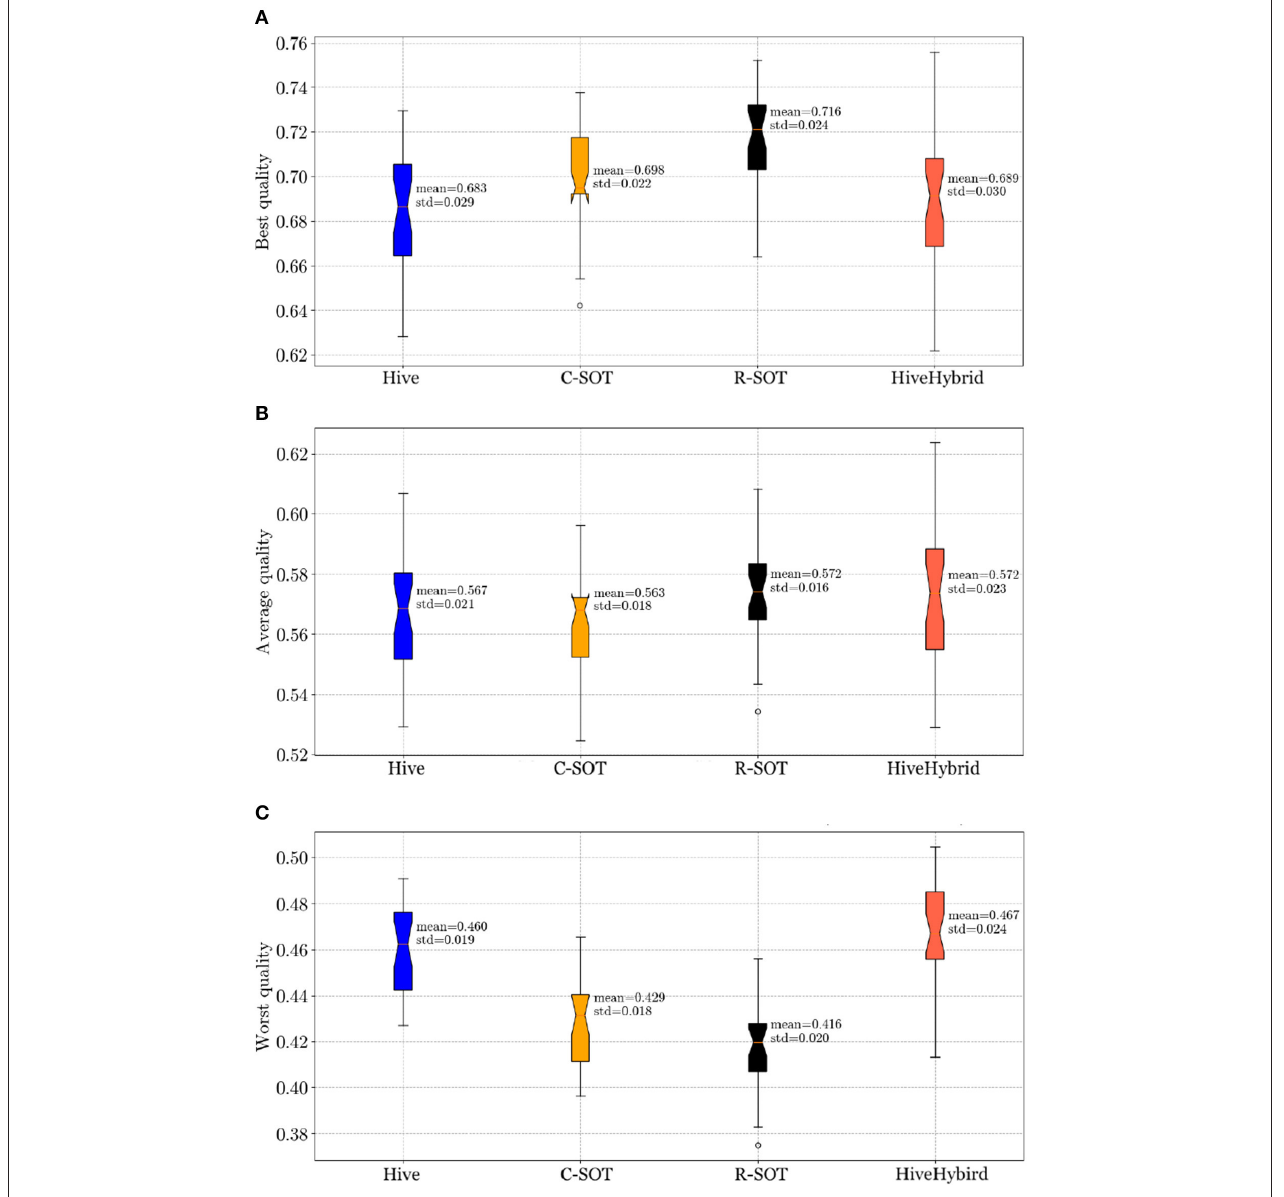
FIGURE 2 | Teamwork quality comparison across four models: Hive, C-SOT, R-SOT, HiveHybrid. The boxplot displays the mean, standard deviation, and standard error of the teamwork quality. Overall, the best teamwork quality (Equation 2) belongs to the bottom-up models R-SOT (mean = 0.716) and C-SOT (mean = 0.698) followed by hybrid (mean = 0.689) and top-down (mean = 0.683). The average performance is fairly equal between models, with HiveHybrid and R-SOT having a slightly higher mean (mean = 0.572). The worst teamwork quality comes from the bottom-up models (R-SOT mean = 0.416, C-SOT mean = 0.429), followed by Hive (mean = 0.460). HiveHybrid performs the best at forming the least worst teamwork quality (mean = 0.467). (A) Best teamwork quality for Hive, C-SOT, R-SOT, and HiveHybrid. (B) Average teamwork quality for Hive, C-SOT, R-SOT, and HiveHybrid. (C) Worst teamwork quality for Hive, C-SOT, R-SOT, and